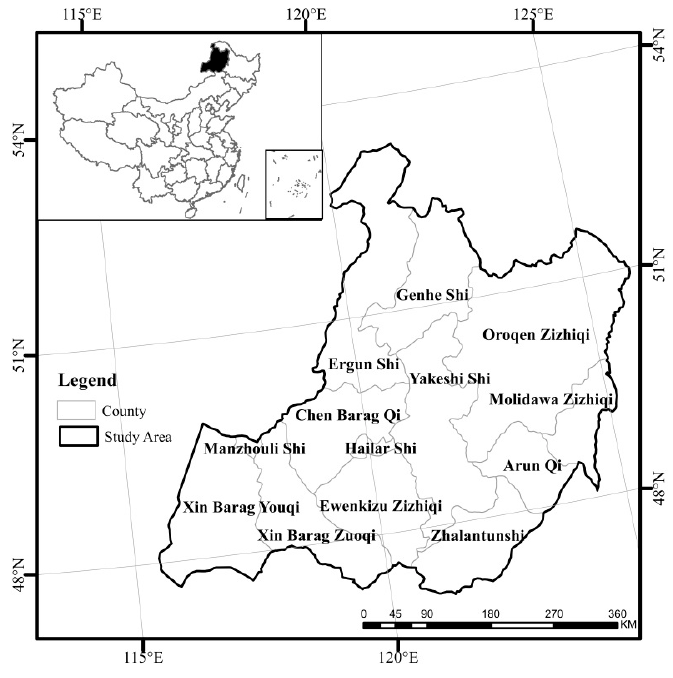
Figure 1. The location of the study area.